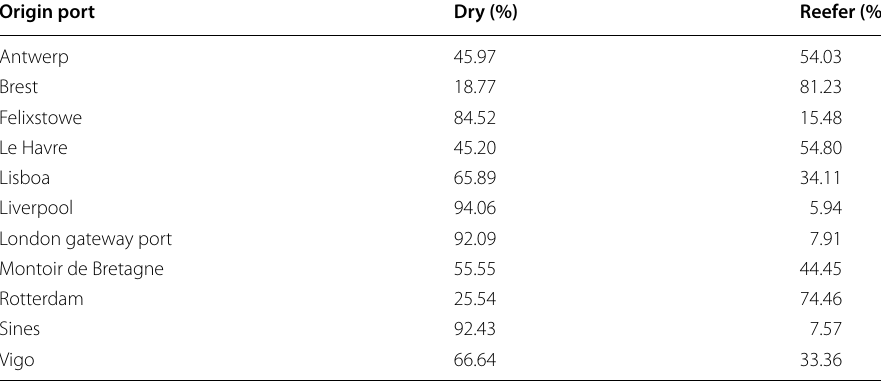
Source: Own elaboration and data based on Port of Las Palmas publications, 2017–18